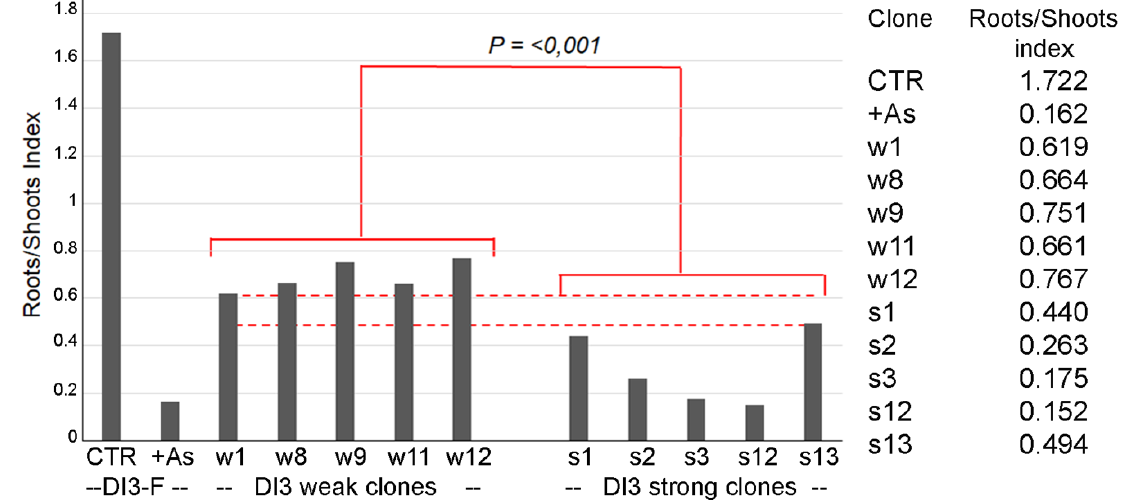
Figure 5. Quantitative real-time polymerase chain reaction of DvNip1.1 in two groups of four plants showing the weakest (weak) or the strongest phenotype (strong). Amplification output values are expressed as 2 −∆Cq ± SD for DvNip1.1 mRNAs (in control condition and after HM stress) and are considered as proportional to the amount of mRNA target according to [27]. The results were showed as roots/shoots index, given by the ratio of the value of DvNip1.1 root 2 −∆ Cq on the value of DvNip1.1 shoot 2 −∆ Cq. Data were submitted to one-way analysis of variance (ANOVA), and differences among two group were detected using comparison procedures within each group (Holm – Sidak test, p < 0.001).